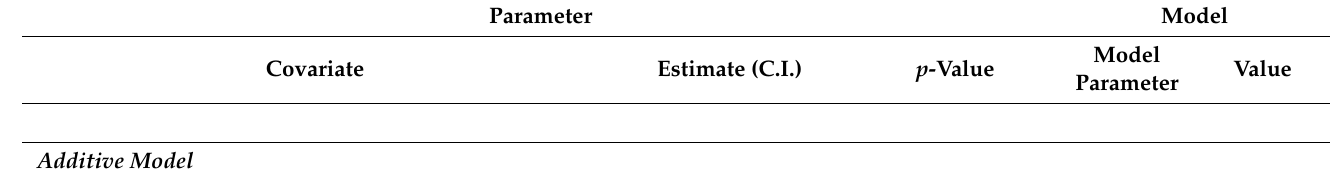
Model Parameter